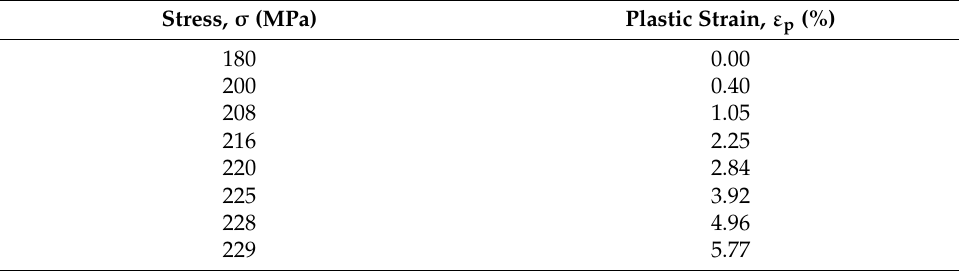
Table 2. AA6060-T6 stress-plastic strain hardening